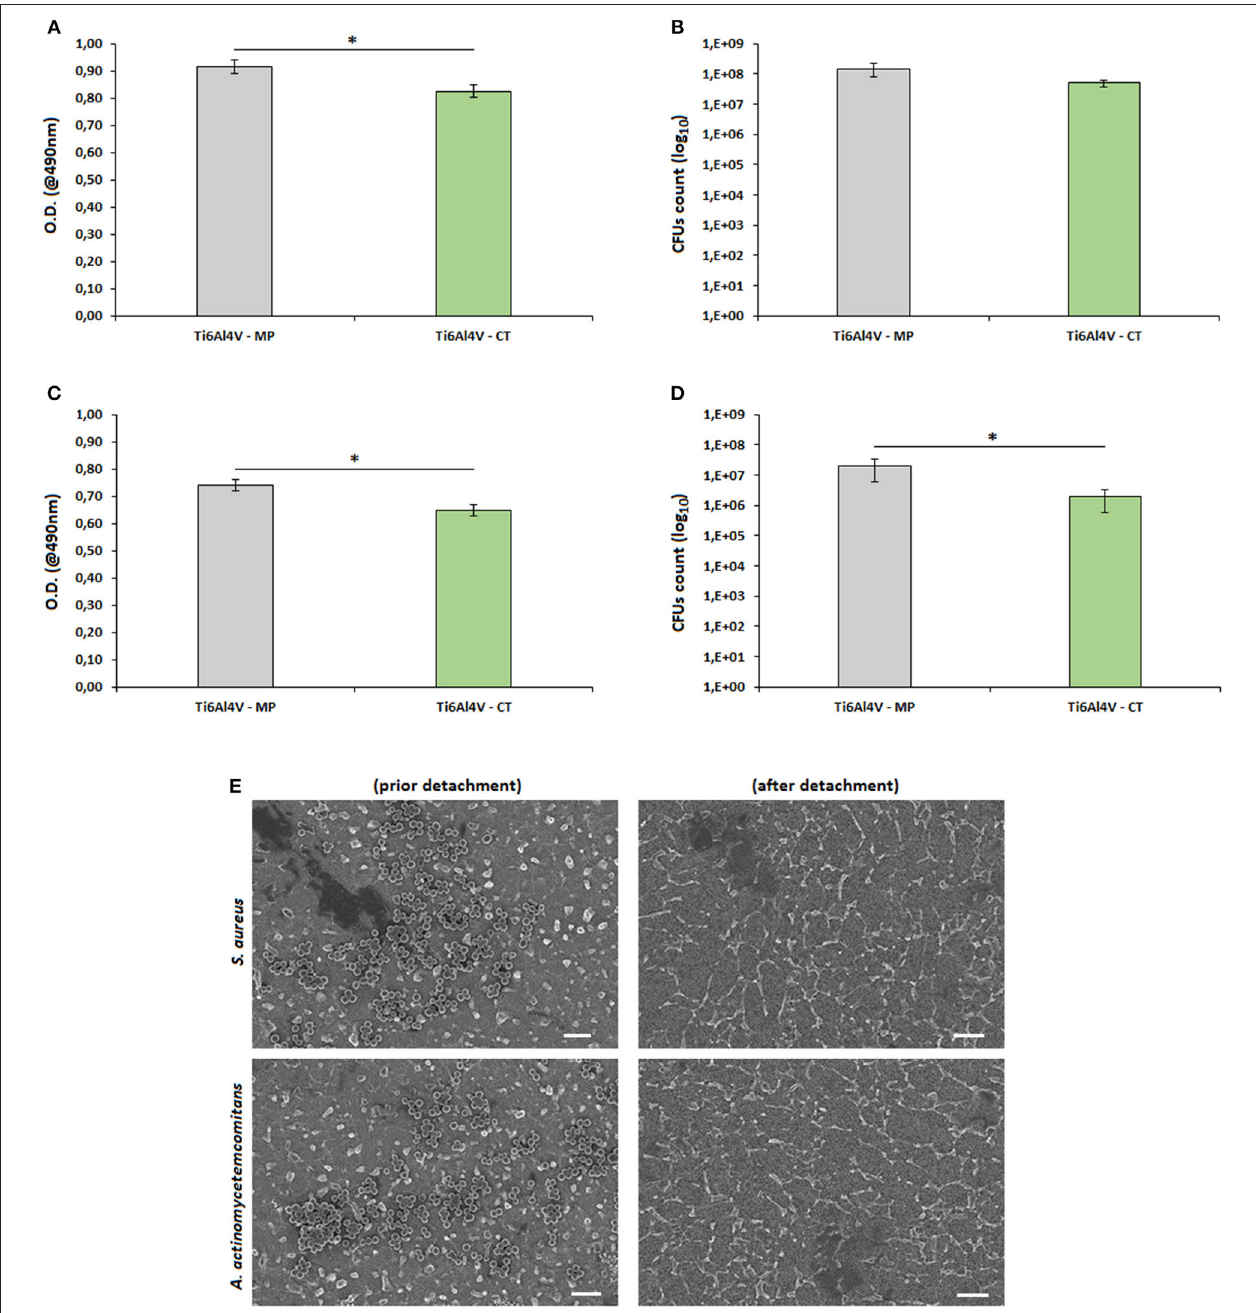
FIGURE 6 | Biofilm adhesion. The surface nanotexture (Ti6Al4V—CT) was able to significantly reduce bacteria metabolism of S. aureus ( A , p < 0.05, indicated by*) and A. actinomycetemcomitans ( C , p < 0.05, indicated by*) in comparison with the smooth controls (Ti6Al4V—MP). This reduction was probably due to the lowering number of adhered bacteria as demonstrated by the reduction of viable colonies count (CFU) of S. aureus ( B , p < 0.05, indicated by *) and A. actinomycetemcomitans ( D , p > 0.05), respectively. Bars represent means and standard deviations. SEM images ( E , bar scale = 2 µ m, magnification = 10,000x) confirmed that bacteria were successfully detached from specimen’s surface and that the detected differences were due to surfaces’ properties.